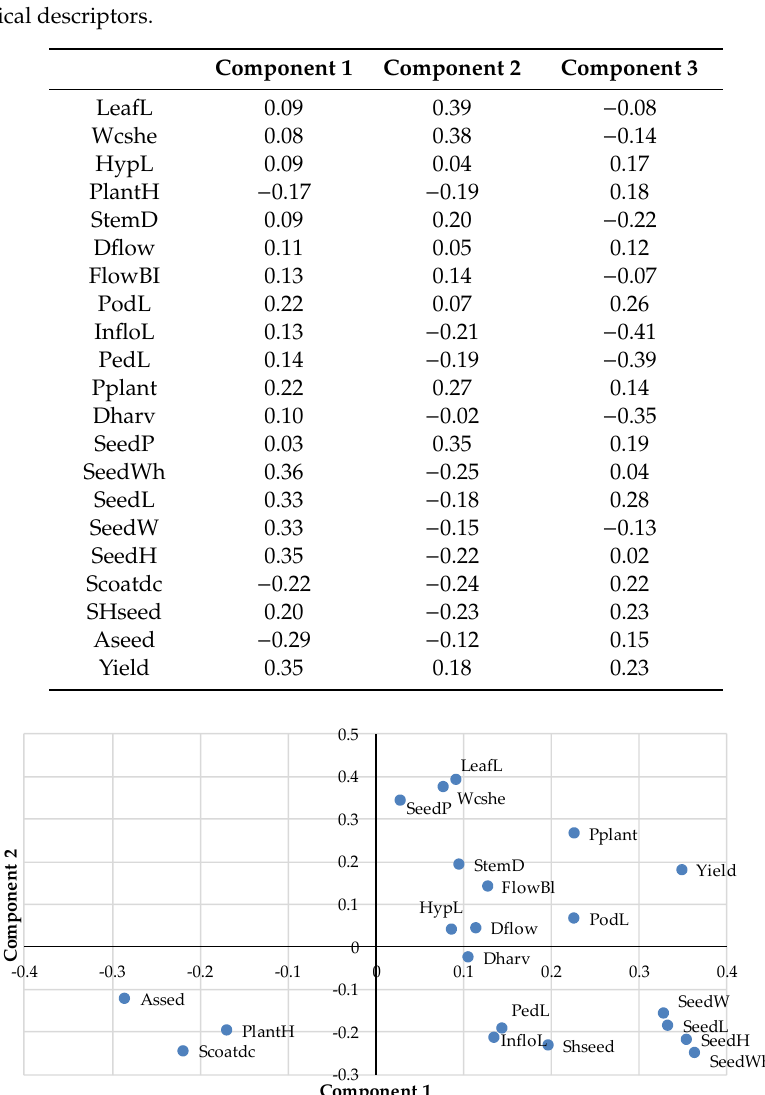
Figure 4. Loading plot of the principal component analysis (PCA) conducted with the quantitative traits analyzed in 24 accessions of P. vulgaris . Abbreviations are as in Table 1.